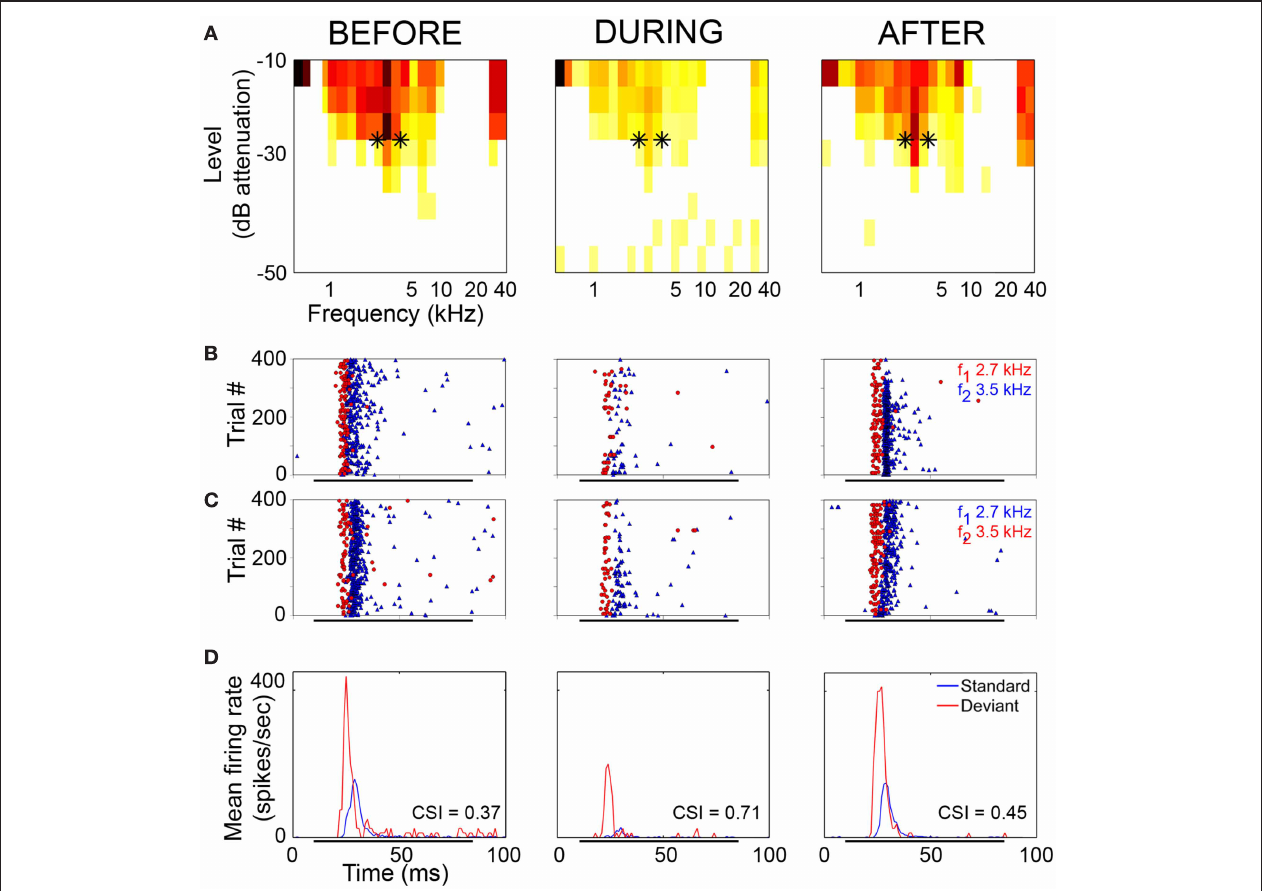
plots showing response to f 1 (lower frequency) as deviant (red circles) and f 2 (higher frequency) as standard (blue triangles). (C) Raster plots showing response to f 1 as standard (blue triangles) and f 2 as deviant (red circles). (D) PSTH showing mean response to standard (blue) and deviant (red) stimuli. CSI values for each period are superimposed onto the relevant PSTH. Reproduced from Anderson and Malmierca